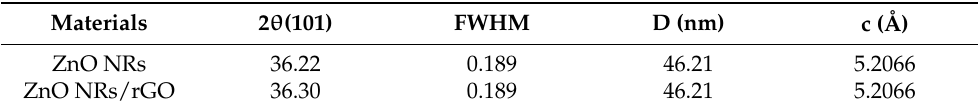
Figure 3. SEM image of the ZnO NRs/rGO ( a ) height distribution, ( b ) diameter distribution, ( c ) mor- phology, and ( d ) XRD spectrum of ZnO, ZnO NRs/rGO, and rGO. Table 3. XRD analysis.